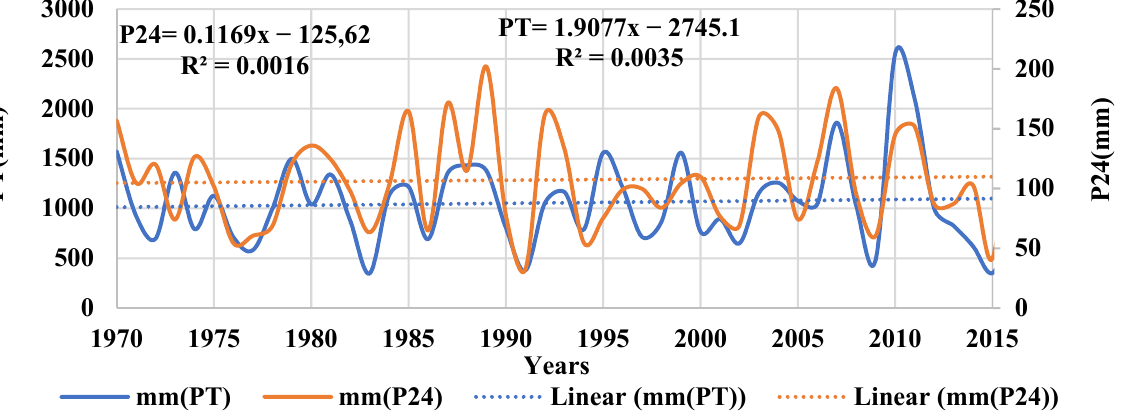
Figure 2. Time series of total annual precipitation and maximum precipitation in 24 h.